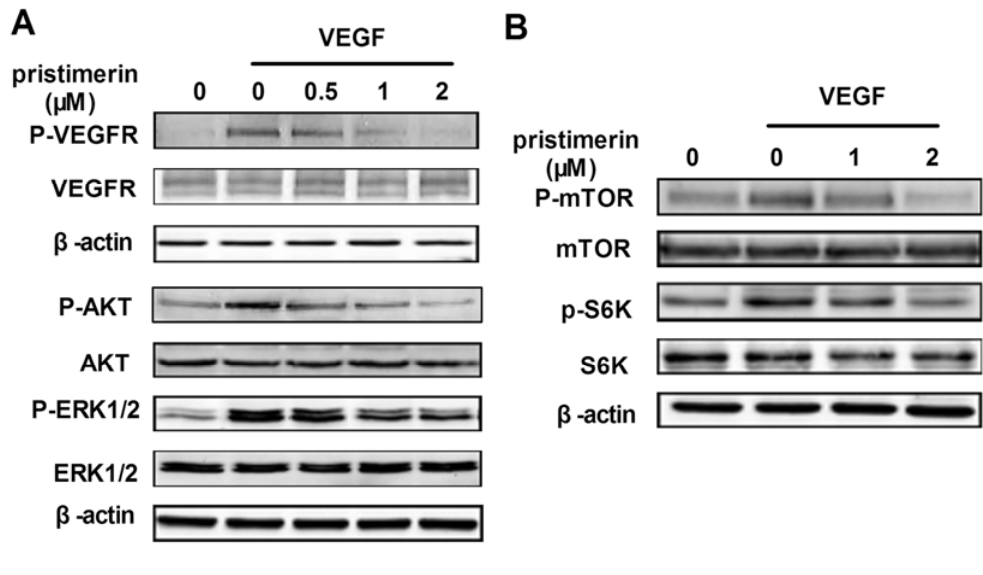
Figure 5. Pristimerin inhibits VEGFR2 kinase activity and its downstream signaling molecules. ( A ) pristimerin suppressed the activation of VEGFR2 and its downstream cascade. The activation of VEGFR2 and ERK/AKT from different treatments was tested by Western blotting and probed specific antibodies; ( B ) The mTOR signaling pathway were suppressed by pristimerin. Proteins from different treatments were analyzed by Western blotting and probed with specific antibodies. Three independent experiments were